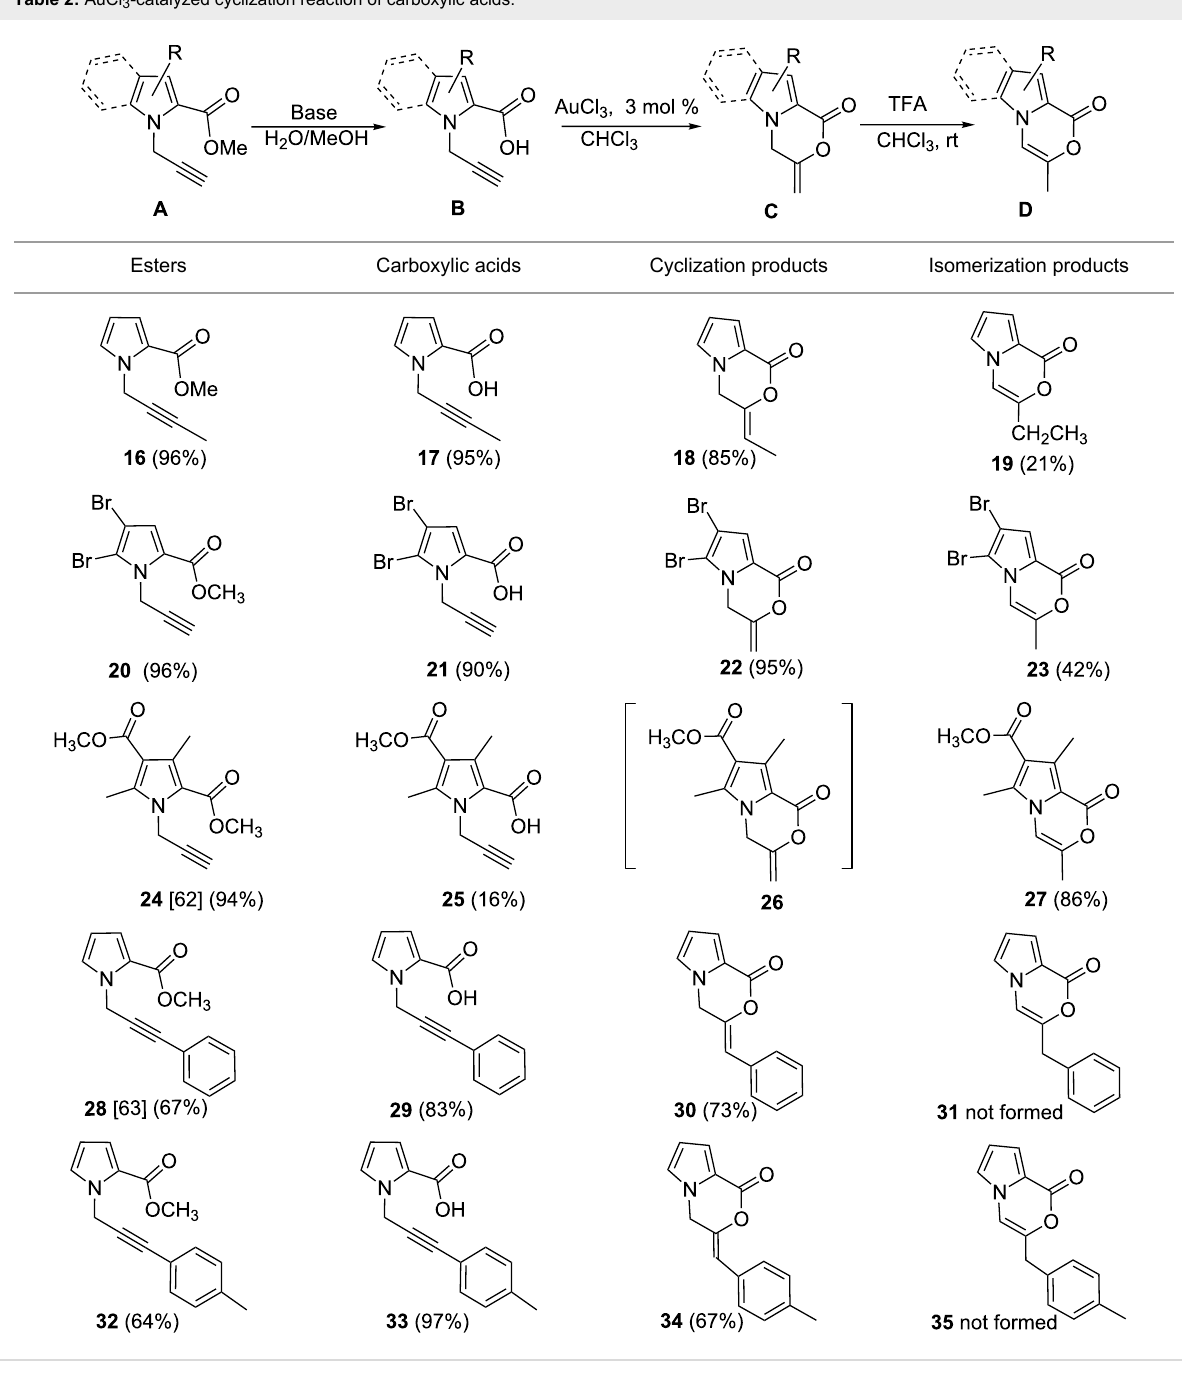
Table 2: AuCl 3 -catalyzed cyclization reaction of carboxylic